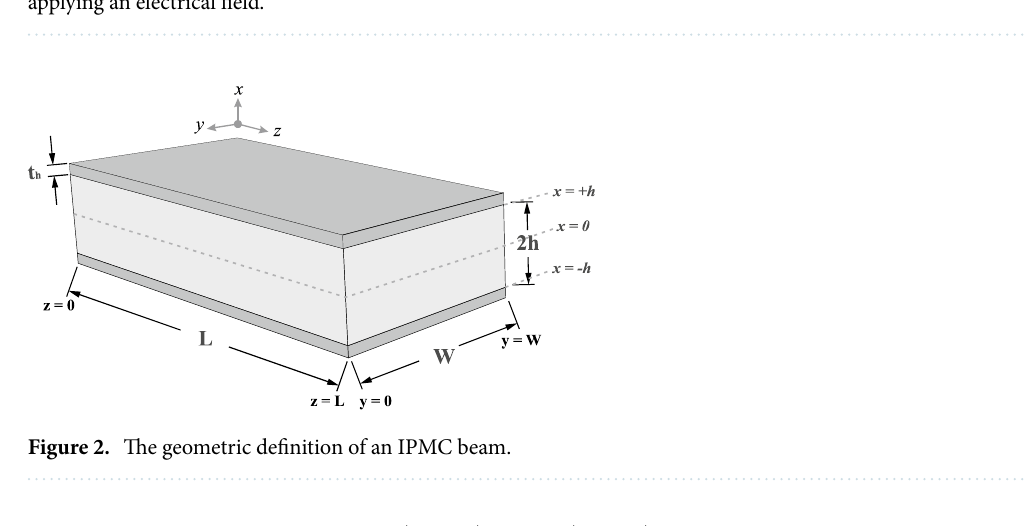
Figure 1. Working principle of an IPMC actuator: (Left) before applying an electrical field; (Right) after applying an electrical field.